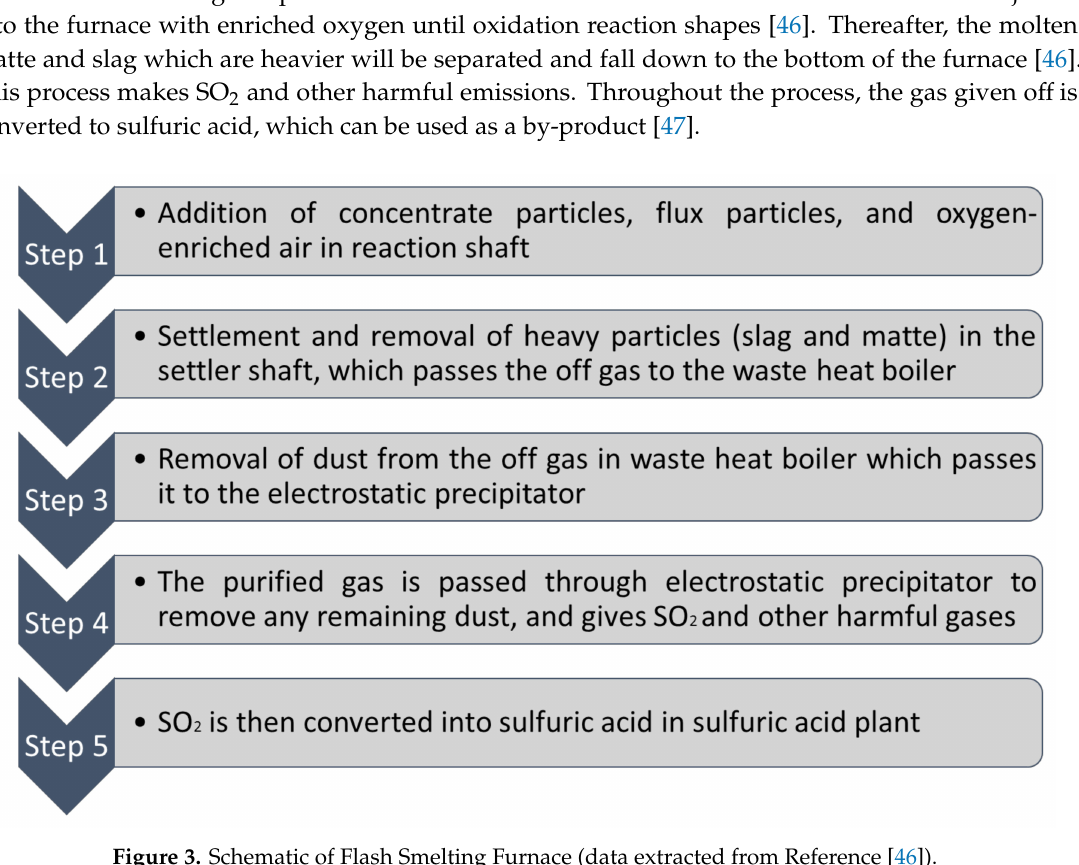
Figure 3. Schematic of Flash Smelting Furnace (data extracted from Reference